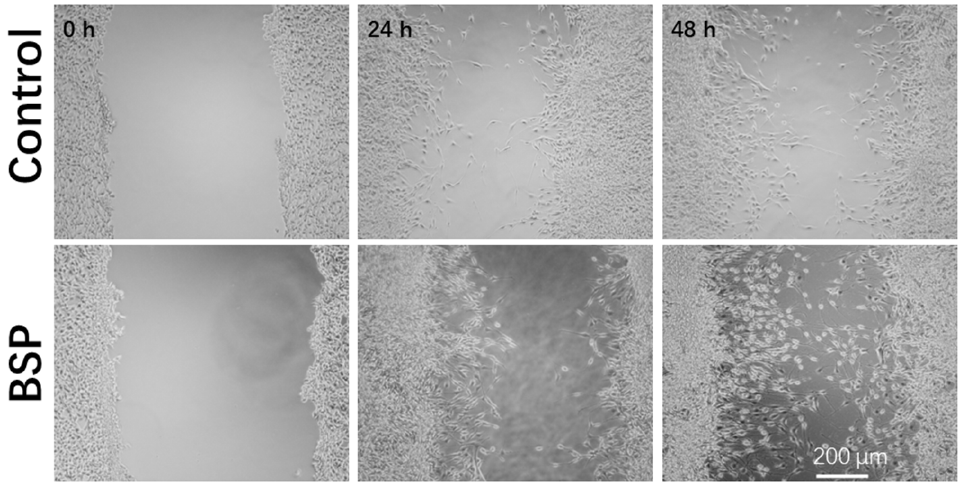
Figure 5. Images of wound scratch migration assay by the cell migration experiment.